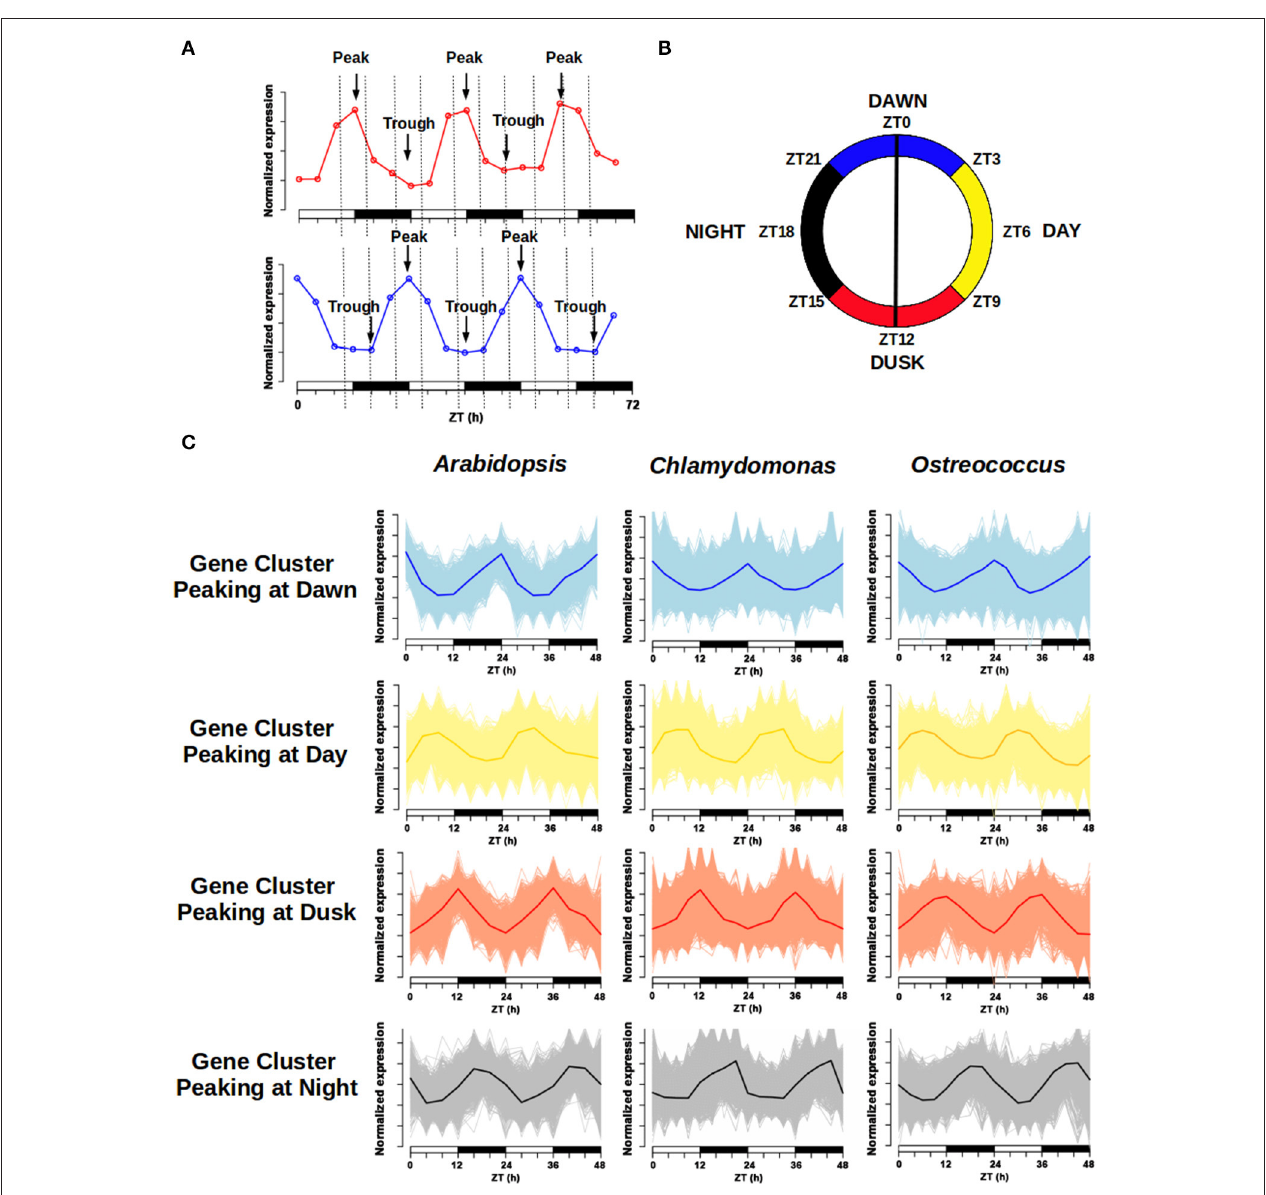
FIGURE 7 | Daily rhythmic gene clustering. The wave form of daily periodic genes expression profile can be characterized by its peak (maximum) and trough (minimum). (A) Example of gene expression for two daily rhythmic genes in a 72 h course. Time is shown in hours (h) as Zeitgeber Time (ZT). The first one exhibits its peak around the light/dark transition and its trough around the dark/light, while the second one presents a symmetric profile. (B) The 24 h day was divided into four different time intervals: “Dawn” was defined as the time interval from ZT21 to ZT3 (blue); “Day” was considered from ZT3 to ZT9 (yellow); “Dusk” consisted of the time period from ZT9 to ZT15 (red) and “Night” was assumed to be from ZT15 to ZT21 (black). (C) Four different clusters were defined for visualization purposes following the same color code: genes peaking at Dawn, Day, Dusk, and Night. A 48h course normalized expression profile of every gene in each cluster was represented, as well as the average gene expression profile for each cluster. Note that the wave form of the average expression profile for each gene cluster is similar in the three different species.